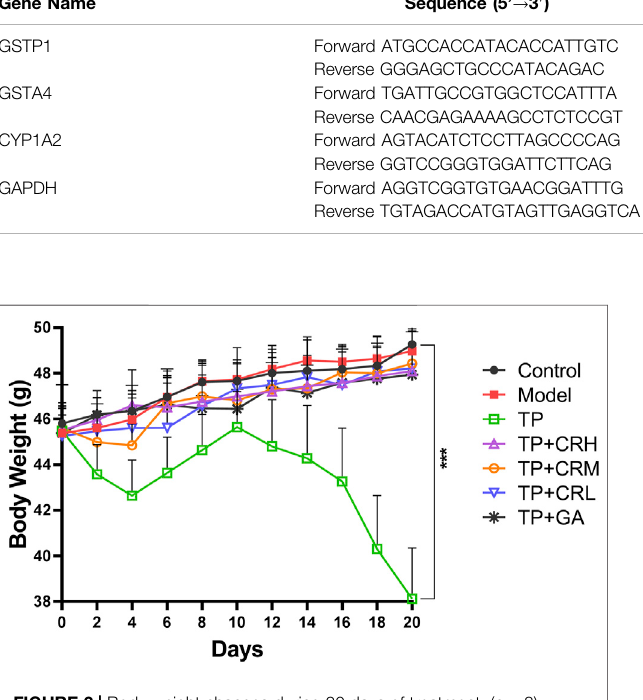
1 . Glyceraldehyde-3-phosphate dehydrogenase (GAPDH) was used as the internal reference gene. The 2 - △△ CT method was used to calculate the relative expression levels of the veri fi ed genes.